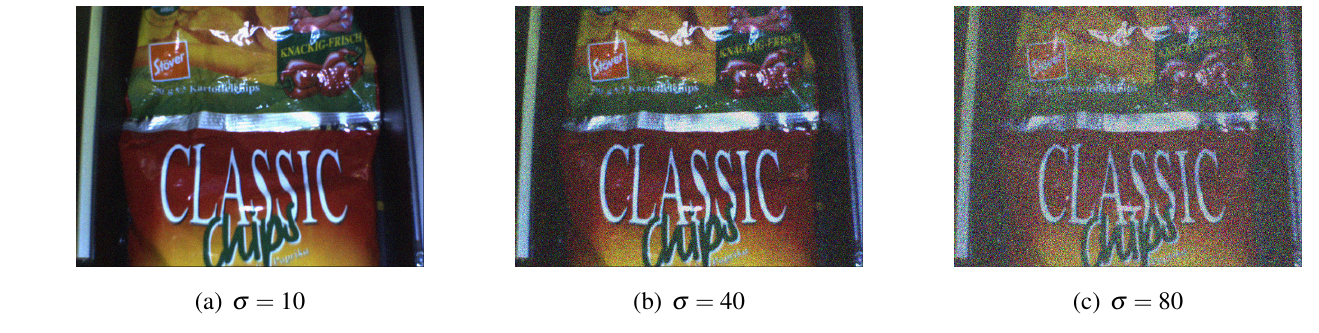
Figure 18. Color marker with Gaussian noise.